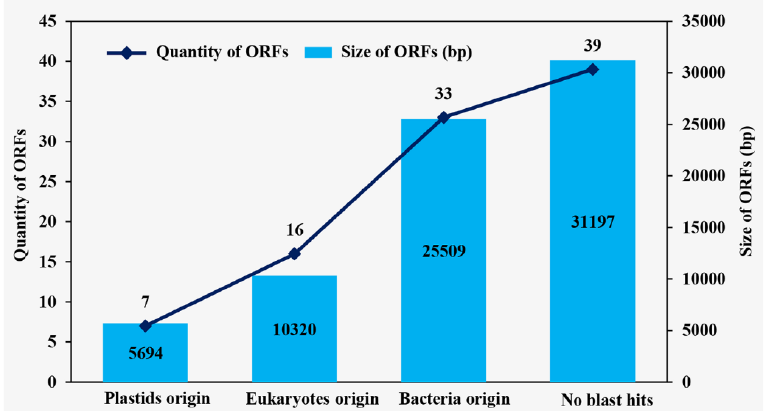
Figure 7. Blast result of free-standing ORFs in Trentepohlia odorata chloroplast genome.